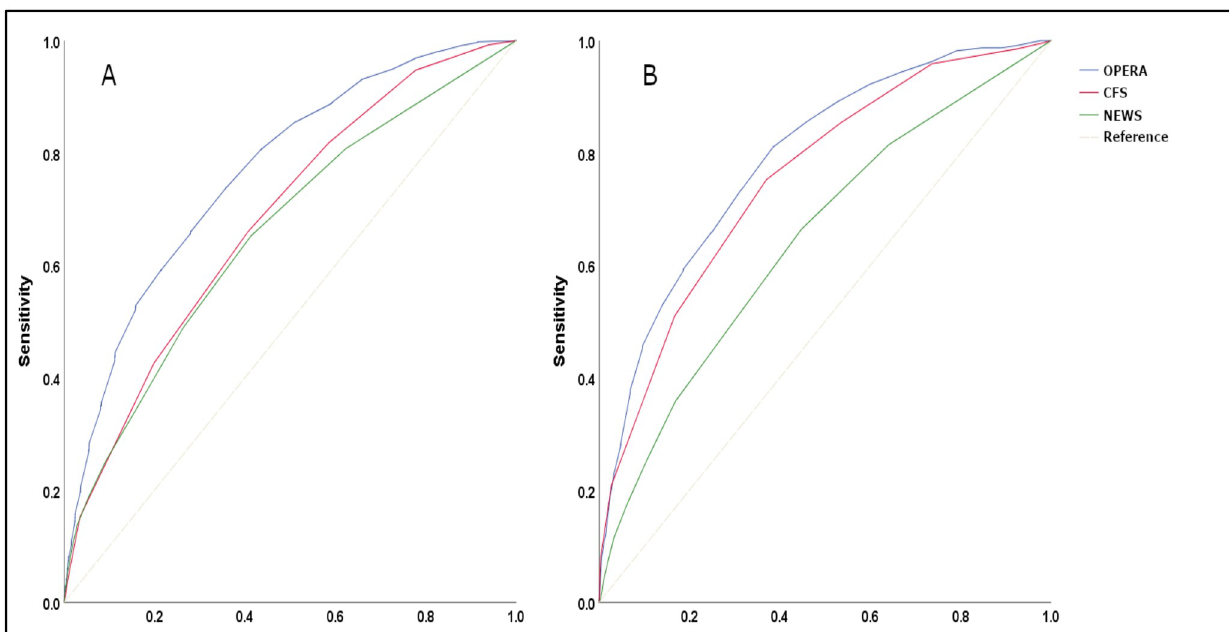
Fig 1. Receiver operating curves for in-hospital mortality for derivation and validation groups. (A) derivation and (B) validation groups. OPERA score (Blue line), CFS (Red line) and NEWS2 (Green line). CFS—clinical frailty scale, NEWS2—national early warning